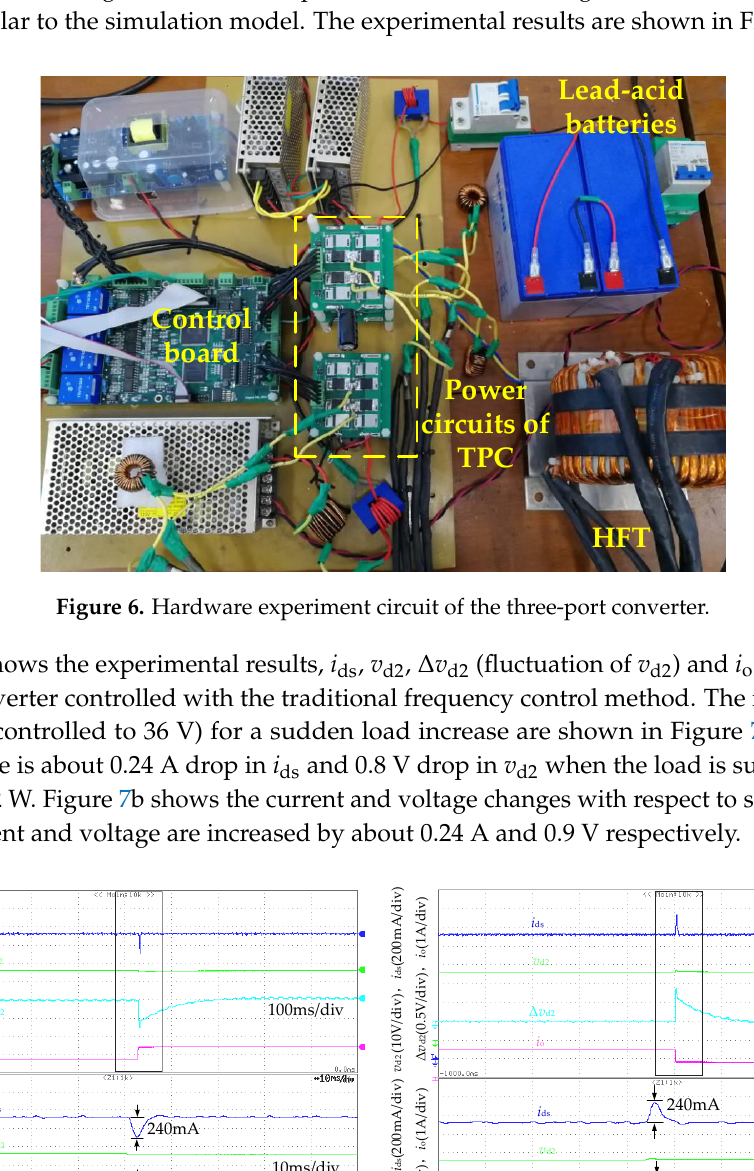
Figure 5. The simulation results of the system: ( a ) with traditional frequency control method; ( b ) with the LADRC method.